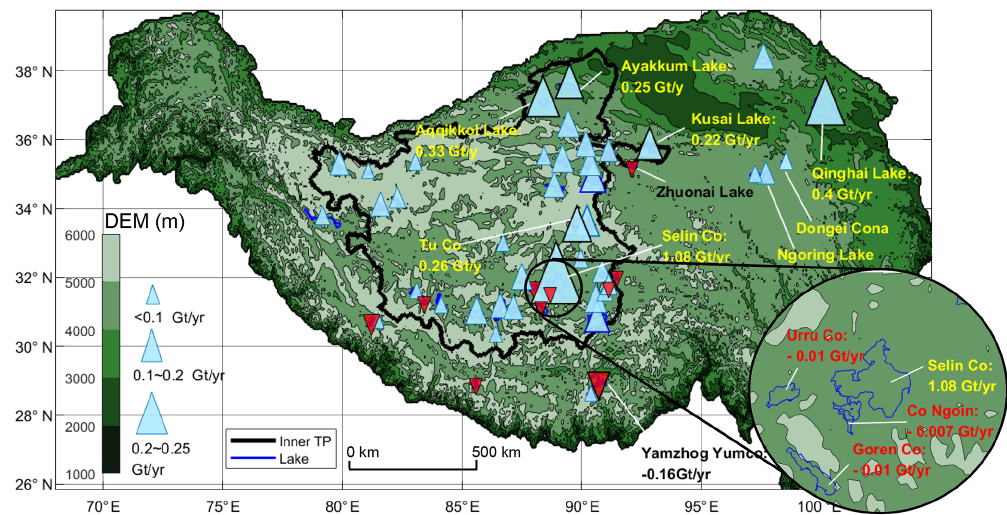
Figure 12. Spatial distribution of trends in lake storage on the TP during 2000–2017. The black line shows the boundary of the endorheic basin of the TP including 39 lakes in this study. The other 13 lakes are located outside the endorheic basin.